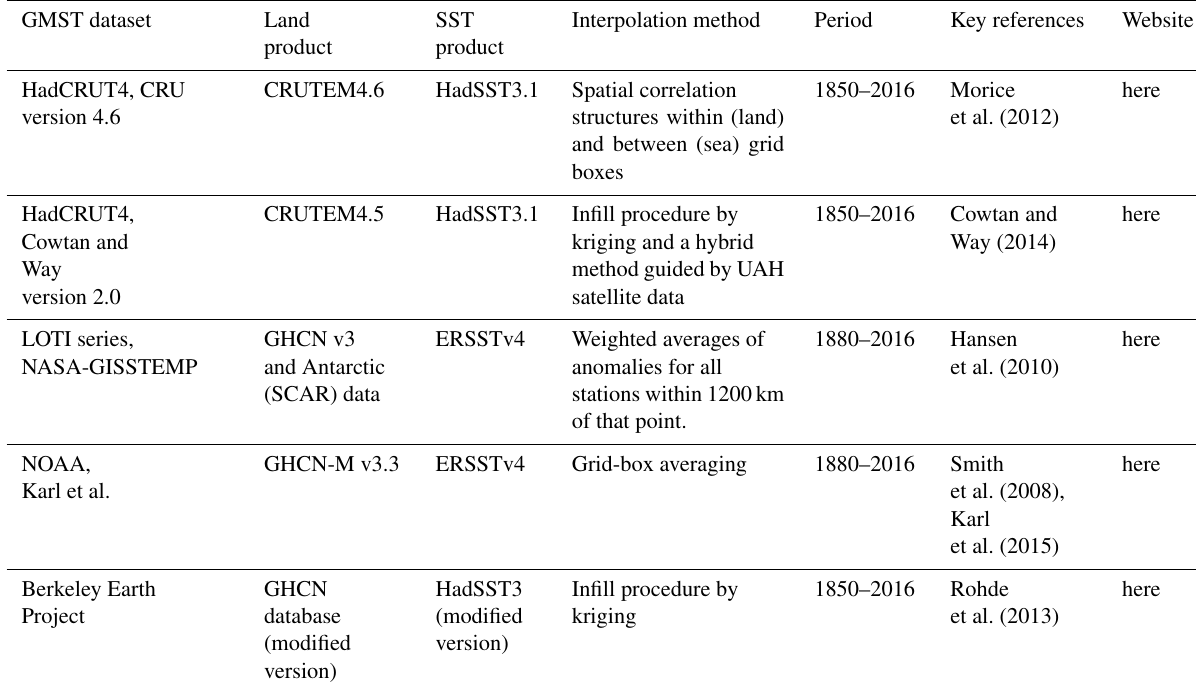
Table 1. Summary of observational datasets used in this study. Descriptions of interpolation schemes are only short indications. Details are given in the